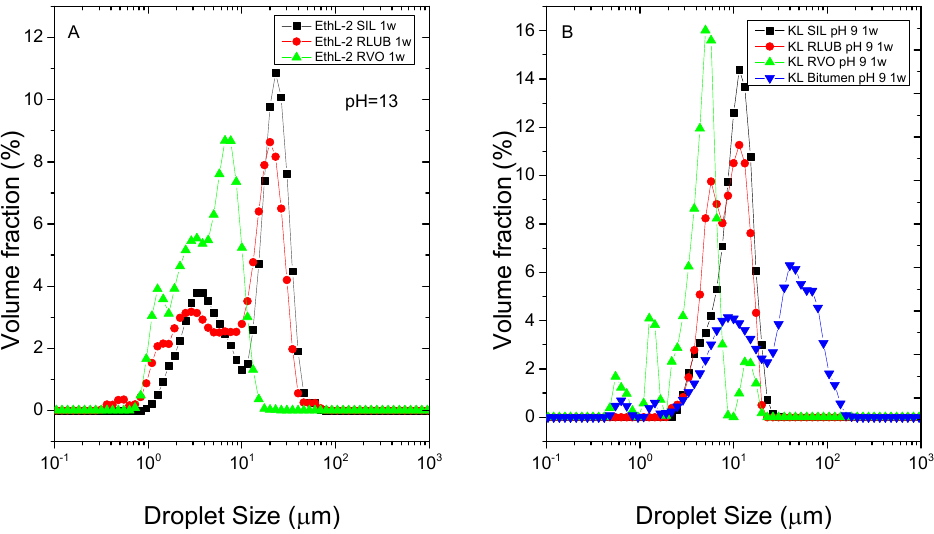
Figure 7. Droplet size distribution of bitumen rejuvenator emulsions stabilized by 0.5 wt.% bioethanol-derived ( A ) and Kraft ( B ) lignins.